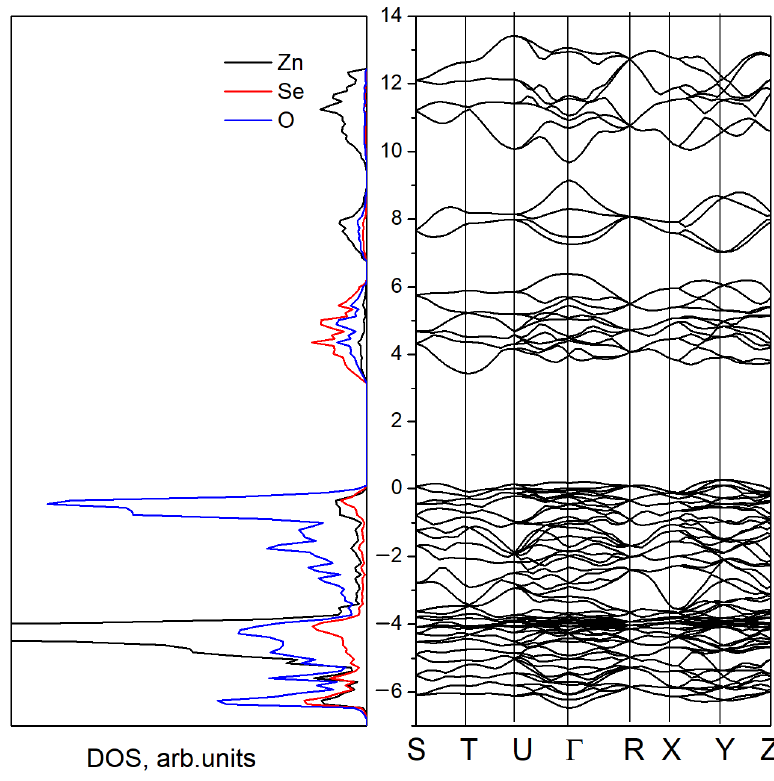
Figure 8. Density of states and band structure of pure ZnSeO 3 crystal.